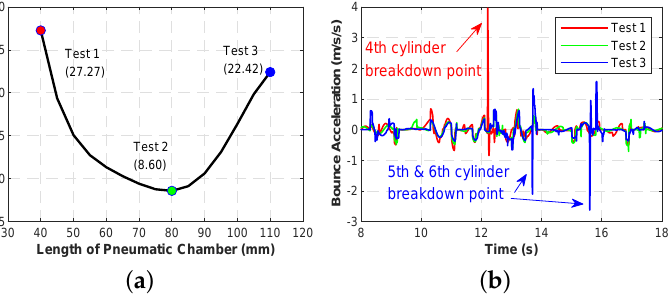
Figure 15. Performance comparison of different initial gas volumes: ( a ) EF value ( b ) Bounce accelera- tion value.